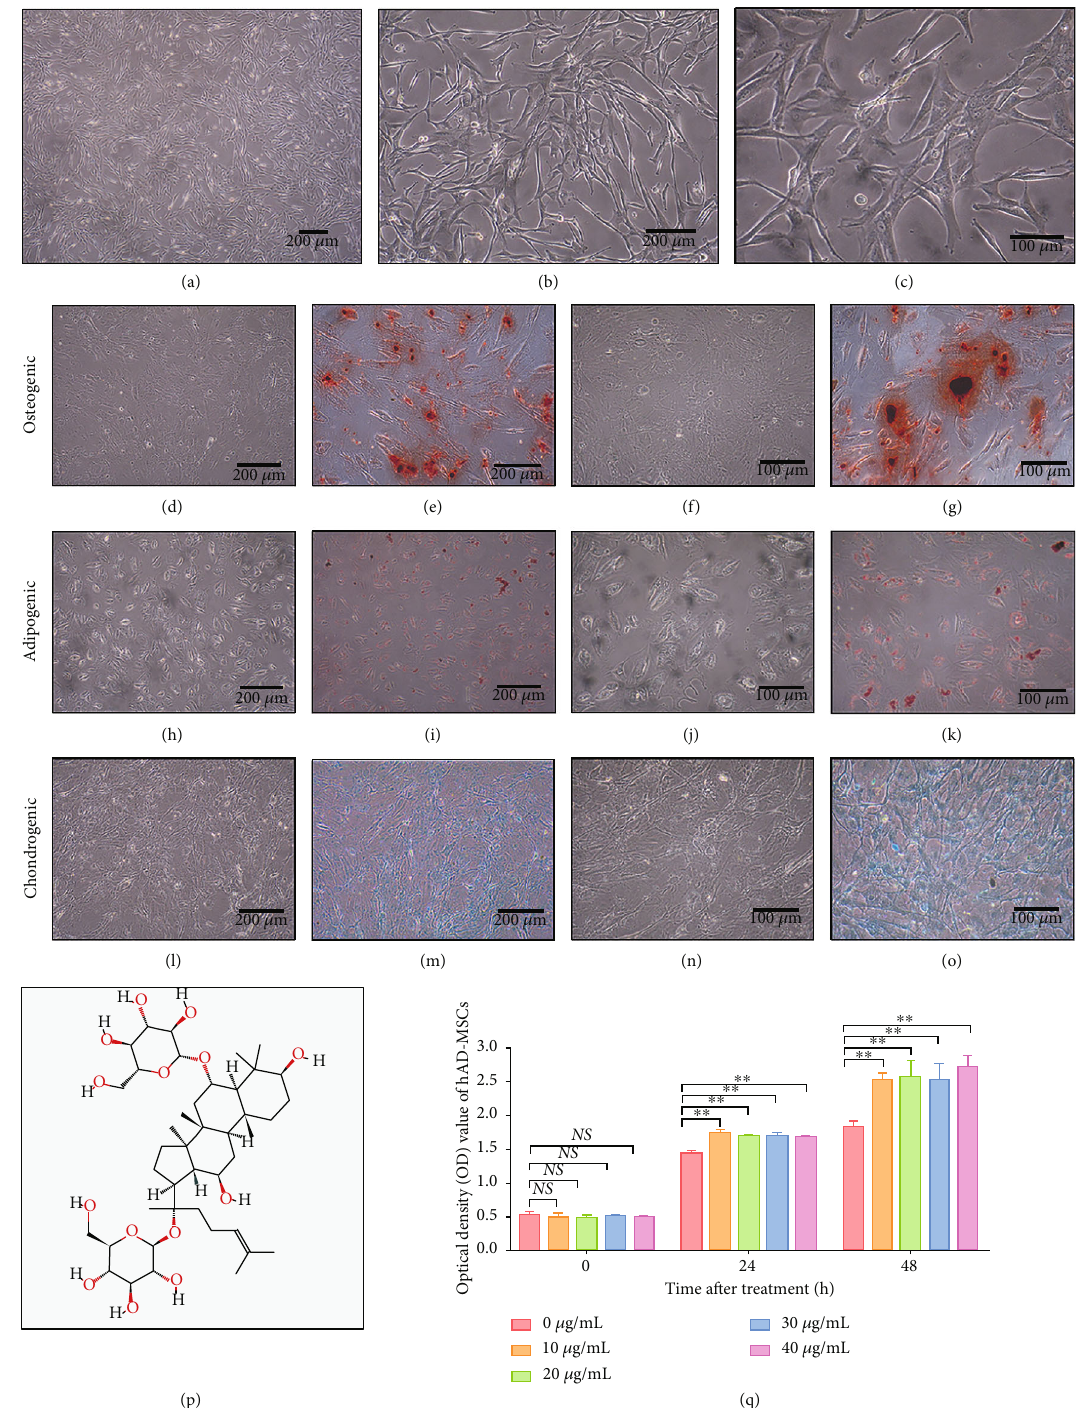
Figure 1: E ff ects of ginsenoside Rg1 on the viability of hAD-MSCs. (a – c) Morphology of hAD-MSCs ((a) × 40, (b) × 100, (c) × 200). (d – o) hAD- MSCs were able to di ff erentiate into osteoblasts (d, f), adipocytes (h, j), and chondroblasts (l, n). The osteogenic di ff erentiation of hAD-MSCs was veri fi ed by alizarin red S, and abundant calcium deposits stained with red were visualized (e, g). The adipogenic di ff erentiation of hAD-MSCs was veri fi ed by oil red O staining, and red lipid vacuoles were visualized in the cytoplasm (i, k). The chondrogenic di ff erentiation of hAD-MSCs was veri fi ed by alcian blue, and cartilage-speci fi c proteoglycans stained with blue were visualized (m, o). (p) The molecular structure of ginsenoside Rg1. (q) The e ff ects of Rg1 with di ff erent concentrations on the viability of hAD-MSCs were detected by CCK-8 assay. Optical density (OD) values at 450nm of each concentration at 24 and 48h after Rg1 treatment were shown ( n =6). Images of (d), (e), (h), (i), (l), and (m) were taken at 100x magni fi cation, while (f), (g), (j), (k), (n), and (o) were taken at 200x. Representative images are shown. Scale bars=100 μ m; Scale bars=200 μ m. NS: not signi fi cant, ∗ P < 0 : 05 and ∗∗ P < 0 : 01